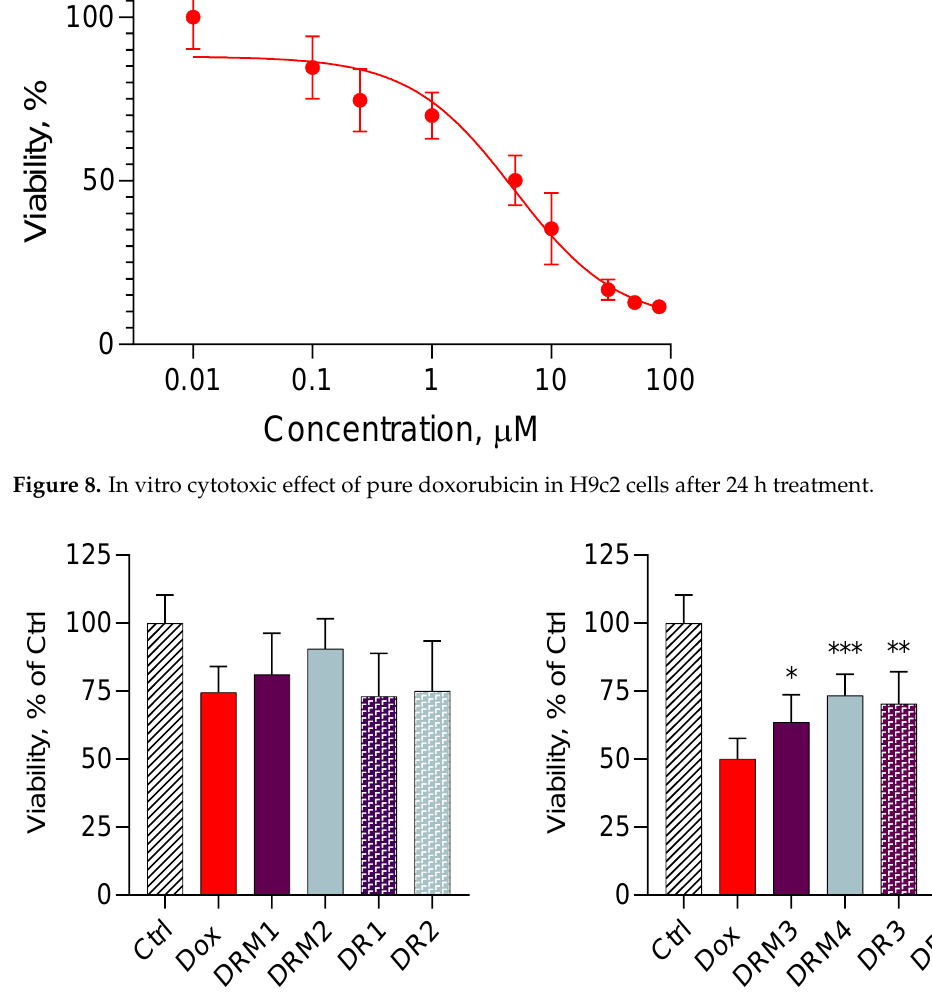
Figure 9. In vitro cell viability of cardioblasts (H9c2) after treatment with the double-loaded doxorubicin/resveratrol micelles (DRM) and referent hydroalcoholic solutions of both drugs (DR). Ctrl—non-treated cells; DRM1 (double-loaded micelles) and DR1 (standard solution) containing 0.25 µM Dox and 1.3 µM Res ( a ); DRM2 (double-loaded micelles) and DR2 (standard solution) containing 0.25 µM Dox and 0.3 µM Res ( a ); DRM3 (double-loaded micelles) and DR3 (standard solution) containing 5 µM Dox and 26 µM Res ( b ); DRM4 (double-loaded micelles) and DR4 (standard solution) containing 5 µM Dox and 6 µM Res ( b ); * p < 0.05; ** p < 0.01; *** p < 0.001 vs. doxorubicin group.